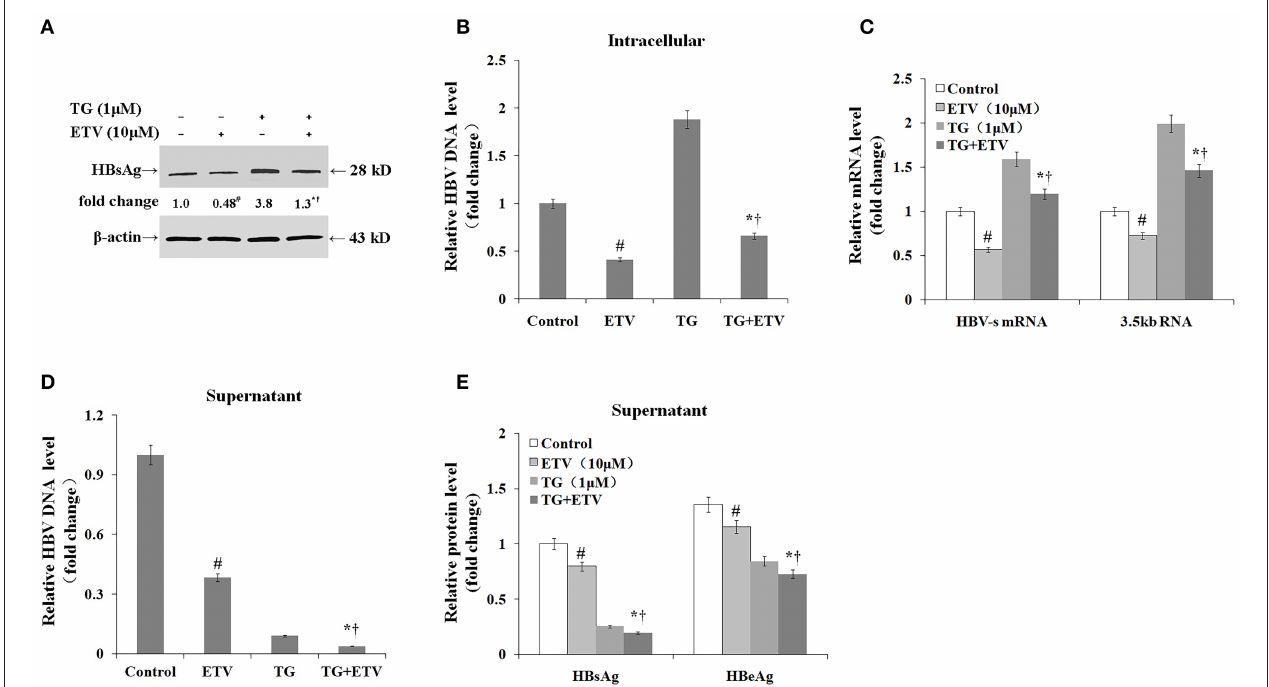
FIGURE 6 | Thapsigargin (TG) delayed intracellular hepatitis B virus (HBV) clearance after entecavir (ETV) treatment. HepG2.2.15 cells were treated with 1 µ M of TG with or without 10 µ M of ETV for 96h. The supernatant levels of HBsAg and HBeAg were determined by ELISA, while those of HBV DNA were determined by qPCR. Intracellular HBsAg, HBV DNA, and HBV RNA levels were determined by western blotting, qPCR, and RT-qPCR, respectively. The results are presented as fold-changes compared with the control or TG group. Histograms represent the means ± SD of three independent experiments. # P < 0.05 vs. the control; * P < 0.05 vs. the TG group; † P < 0.05 vs. the ETV group. (A) Intracellular HBsAg levels as determined by western blotting. Representative blots from three independent experiments are shown. (B) Intracellular HBV DNA levels as determined by qPCR. (C) Intracellular HBV RNA levels as determined by RT-qPCR. (D) HBV DNA levels